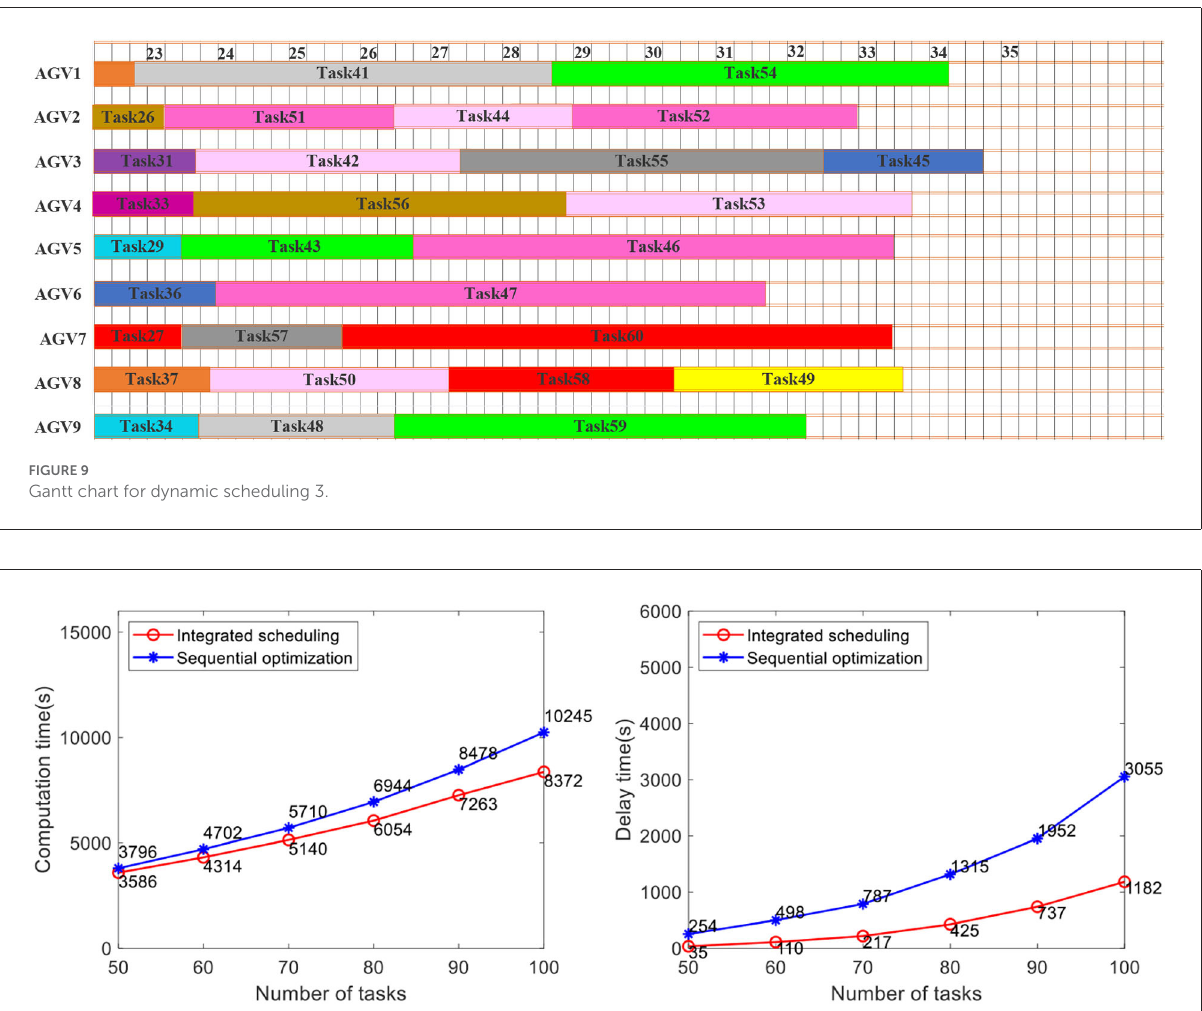
FIGURE10 Comparative analysis of task completion time and delay time with 5